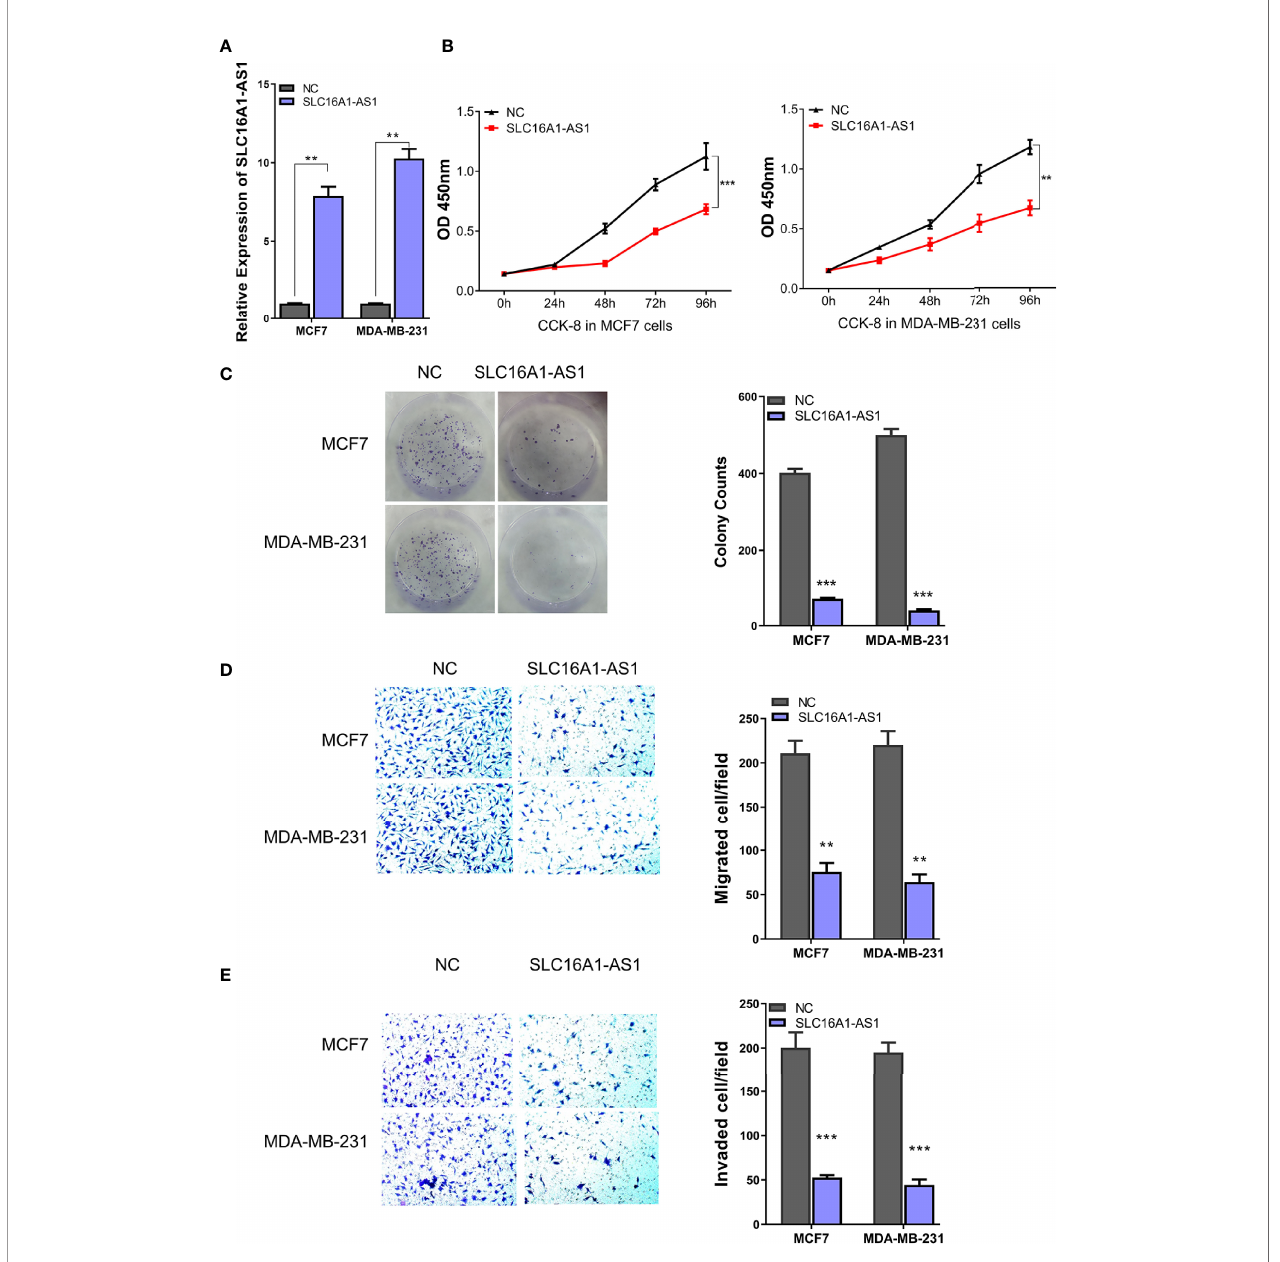
FIGURE 2 | Silencing SLC16A1-AS1 promotes viability, colony formation, invasion, and migration of BC cells. To further explore the functions of SLC16A1-AS1 in BC progression, SLC16A1-AS1 was silenced in MDA-MB-453 and BT474 cells. After being con fi rmed that SLC16A1-AS1 was effectively silenced in both MDA-MB- 453 and BT474 cells (A) , the following behaviors were compared between SLC16A1-AS1 silenced and the negative control (NC) MDA-MB-453 and BT474 cells: cell viability (B) , colony formation (C) , cell migration (D) , and cell invasiveness (E) in Figures 2 all were quanti fi ed with symbol *. * p < 0.05, ** p < 0.01, *** p < 0.001.